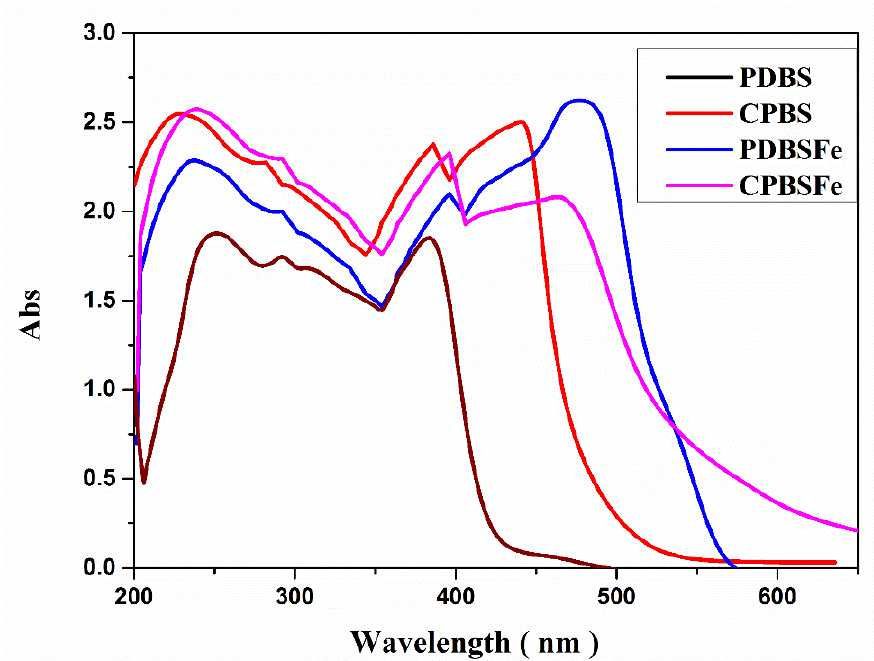
Figure 1. UV-vis scanning of PDBS and CPBS ligands and their metal chelates in EtOH media at 25 °C.